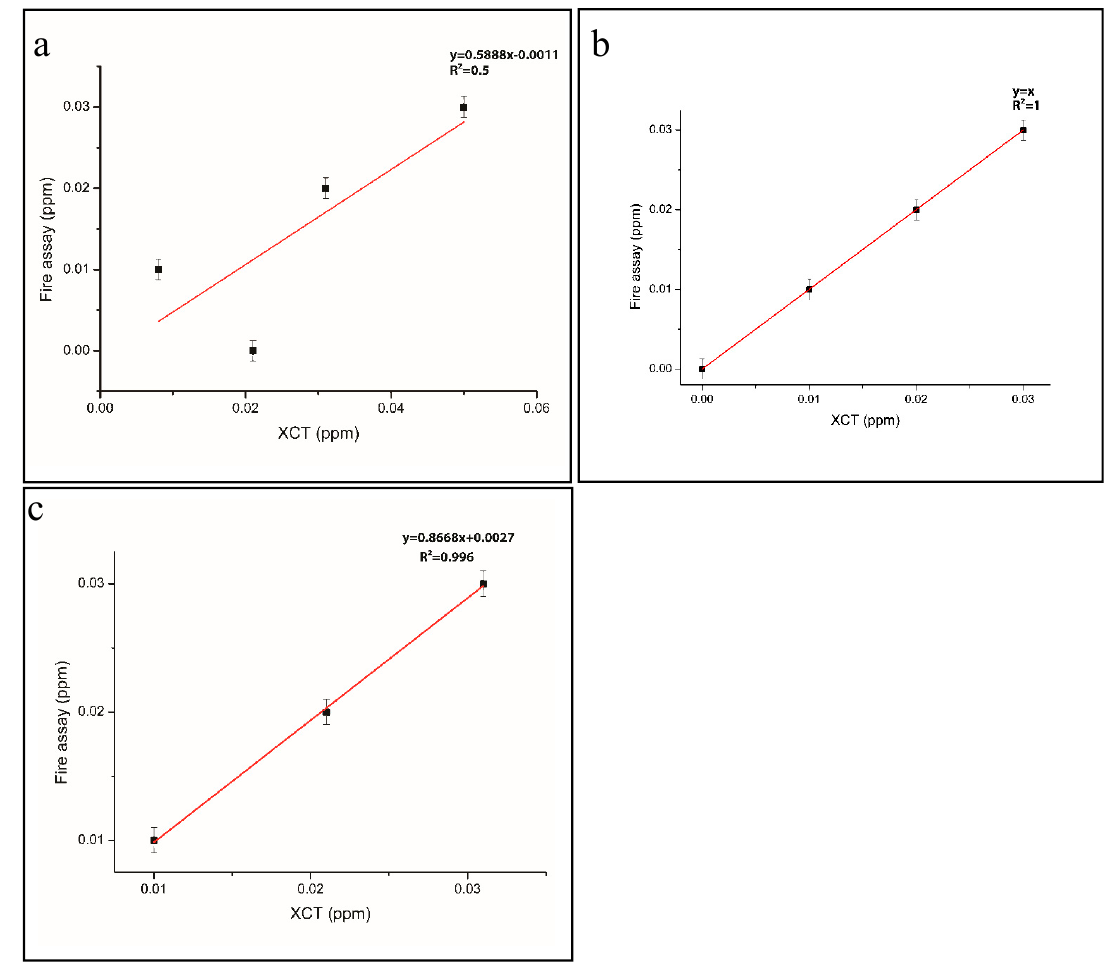
Figure 6. Correlation between XCT and Fire assay data. ( a ) Correlation between XCT and fire assay of quarter core before calibration. ( b ) 1:1 linear best fit line of XCT and fire assay. ( c ) Correlation between XCT and fire assay of quarter core after calibration. Error bar ± 0.001. Table 3. (Top) Gold grade of the scanned core samples calculated by XCT analysis and gold grade obtained by fire assay. (Middle) Calculated gold grade after calibrating using fire assay at threshold grey value of 63,000. (Bottom) comparison of gold grades before and after calibration. Gold Volume Sample Weight of Core (g) (cm3)